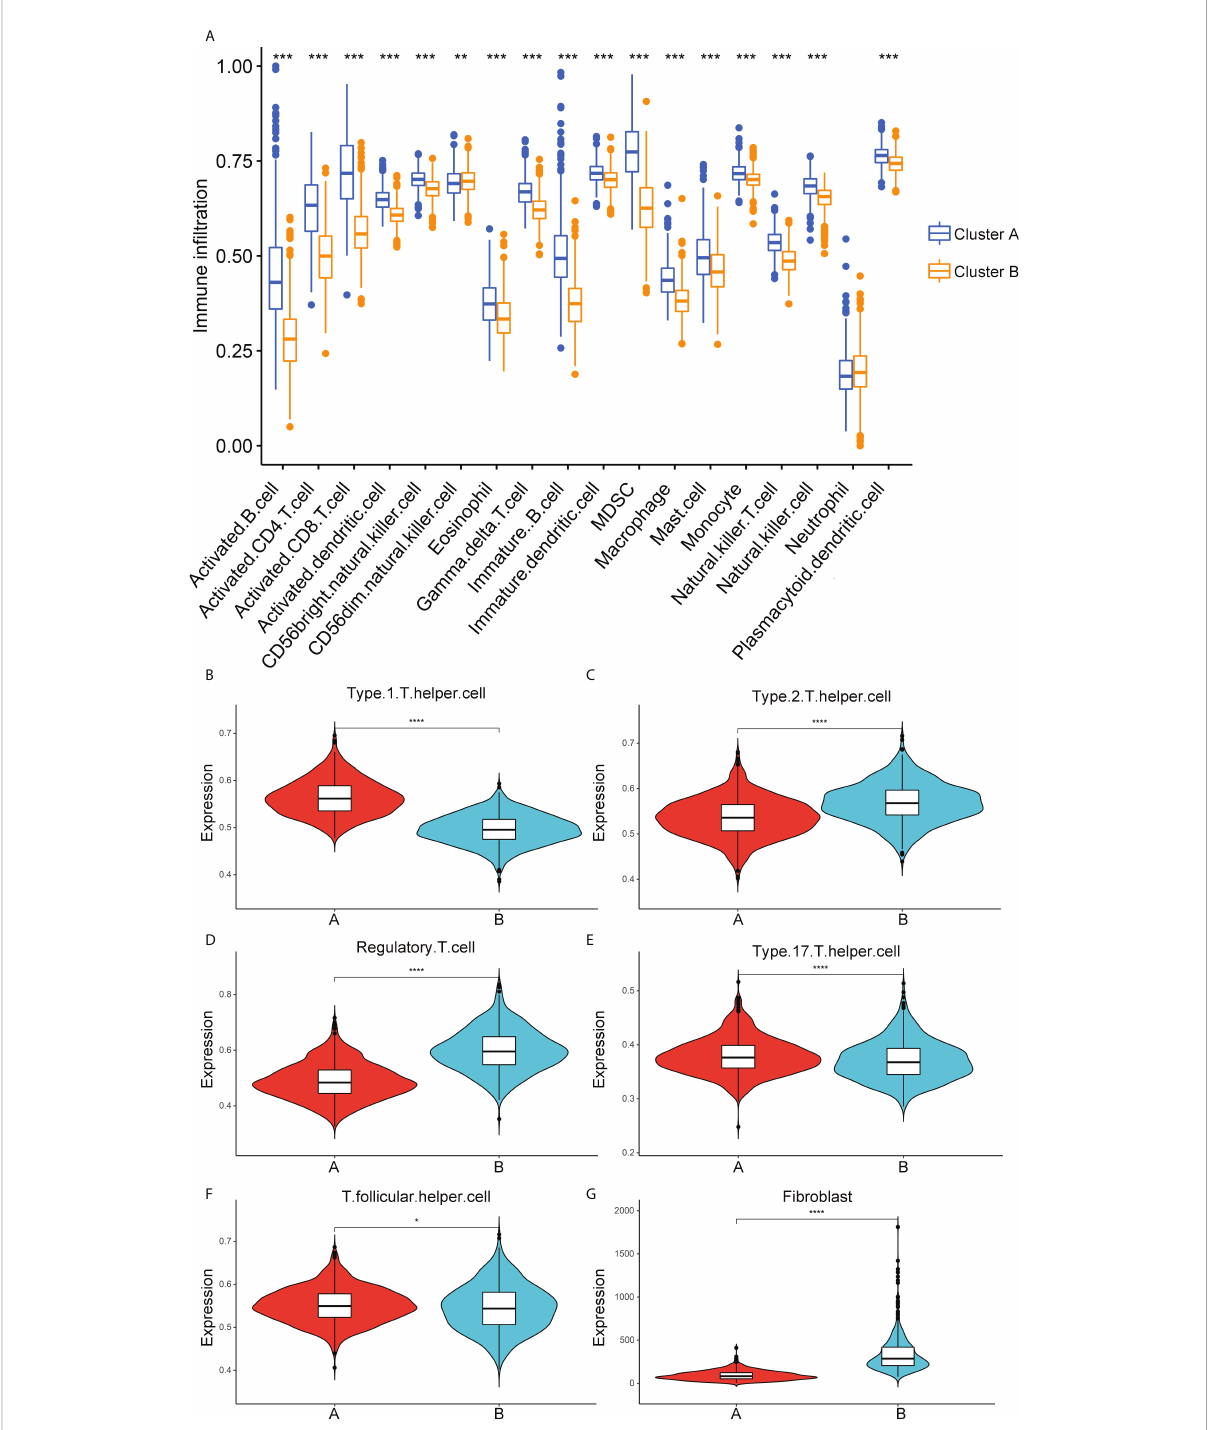
FIGURE 2 Correlation analysis between immune cell in fi ltration and ECM-clusters. (A) Distribution of the relative abundance of 18 immune cells obtained by ssGSEA algorithm in different ECM-clusters. B-F. Relative contents of Th cell subpopulations, including Th1 (B) , Th2 (C) , Treg (D) , Th17 (E) and Tfh (F) cells in different ECM-clusters. (G) Relative abundance of fi broblasts in different ECM-clusters calculated by MCP-counter algorithm. ssGSEA, single-sample gene set enrichment analysis; Th cell, T helper cell; Th1, type 1 T helper cell; Th2, type 2 T helper cell; Treg, regulatory T cell; Th17, type 17 T helper cell; Tfh, T follicular helper cell; MCP-counter, Microenvironment Cell Populations-counter; * p <0.05; ** p <0.01; *** p <0.001; **** p